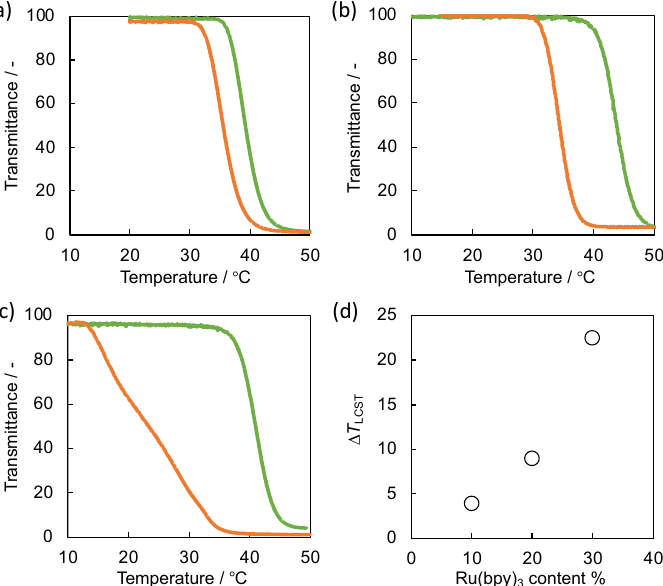
Figure 4. Temperature dependence of optical transmittance for the aqueous solutions containing ( a ) SOP-10, ( b ) SOP-20 and ( c ) SOP-30 in reduced state (orange) and oxidized state (green). ( d ) The dependence of ∆ T LCST on Ru(bpy) 3 content.